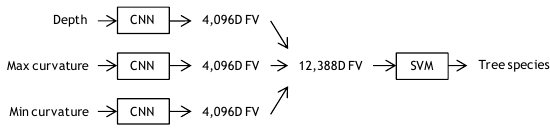
Figure 7. Our multi-modal classification stream